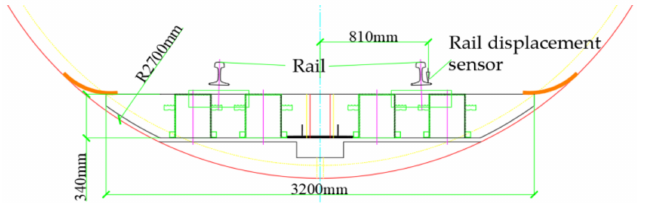
Figure 4. Layout of measuring points for vertical displacement test of the rail relative to the track